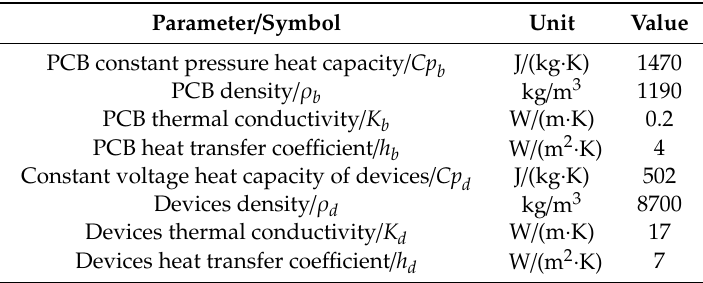
Table 3. Physical parameters.